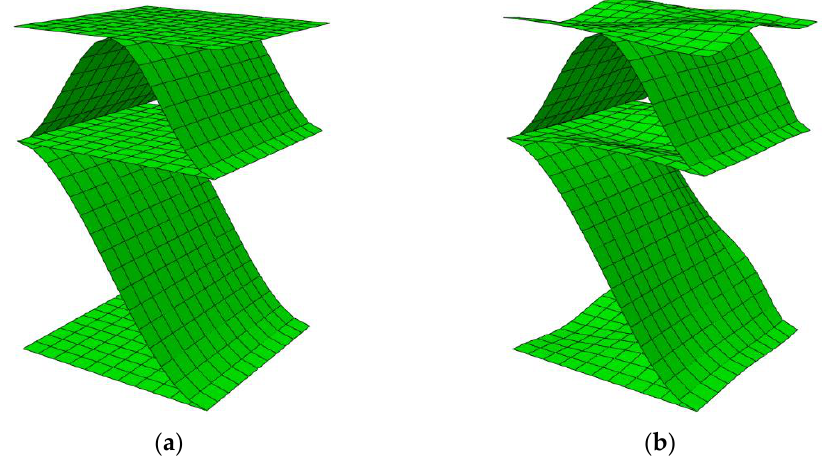
Figure 3. Model of BC-790 five-layered corrugated board: ( a ) without imperfections; ( b ) with imperfections (scale ×10).